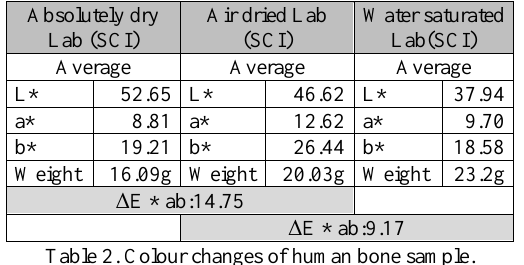
Table 2. Colour changes of human bone sample.